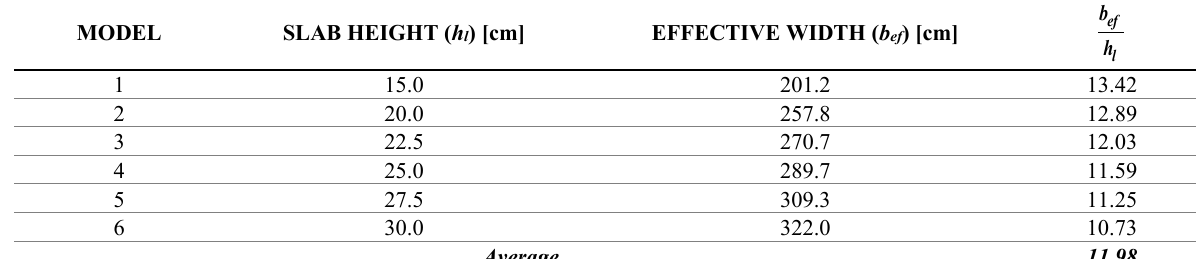
Table 4. Relationship between the effective numerical width and the slab height for simple box con figuration.